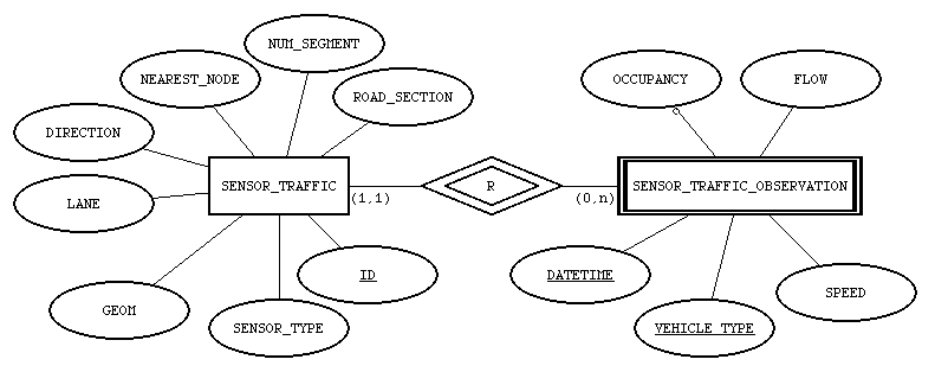
Figure 3. E/R schema with the entity types of the TRAFAIR data platform used to collect the measurements of the traffic